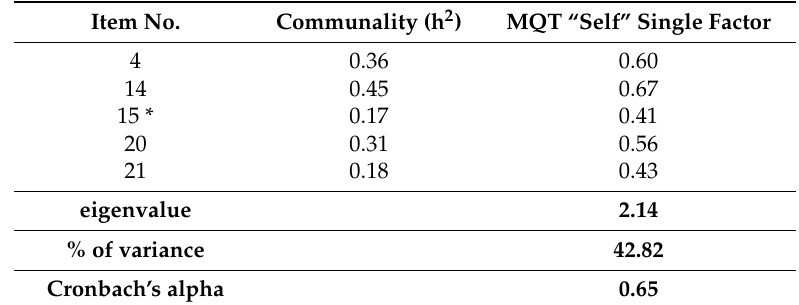
Table 9. EFA single-factor solution after the direct oblimin rotation of the MQT “self” items after having removed items with low communality and factor